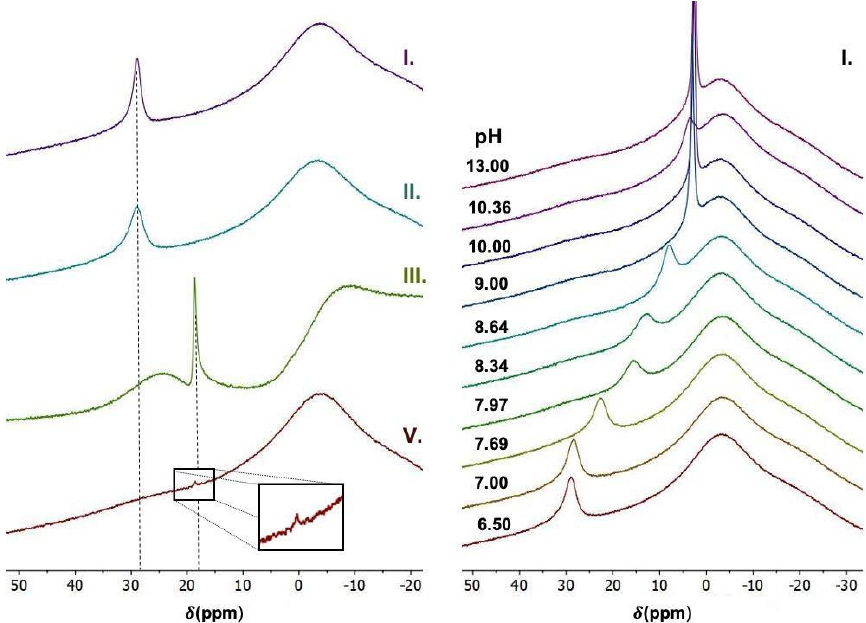
Figure 2. Left : 11 B NMR spectra of (I) FPBA, (II) Pyr-FPBA, (III) P4VP-FPBA and (V) SVE-FPBA. Right : 11 B NMR spectra of FPBA at various pH levels.